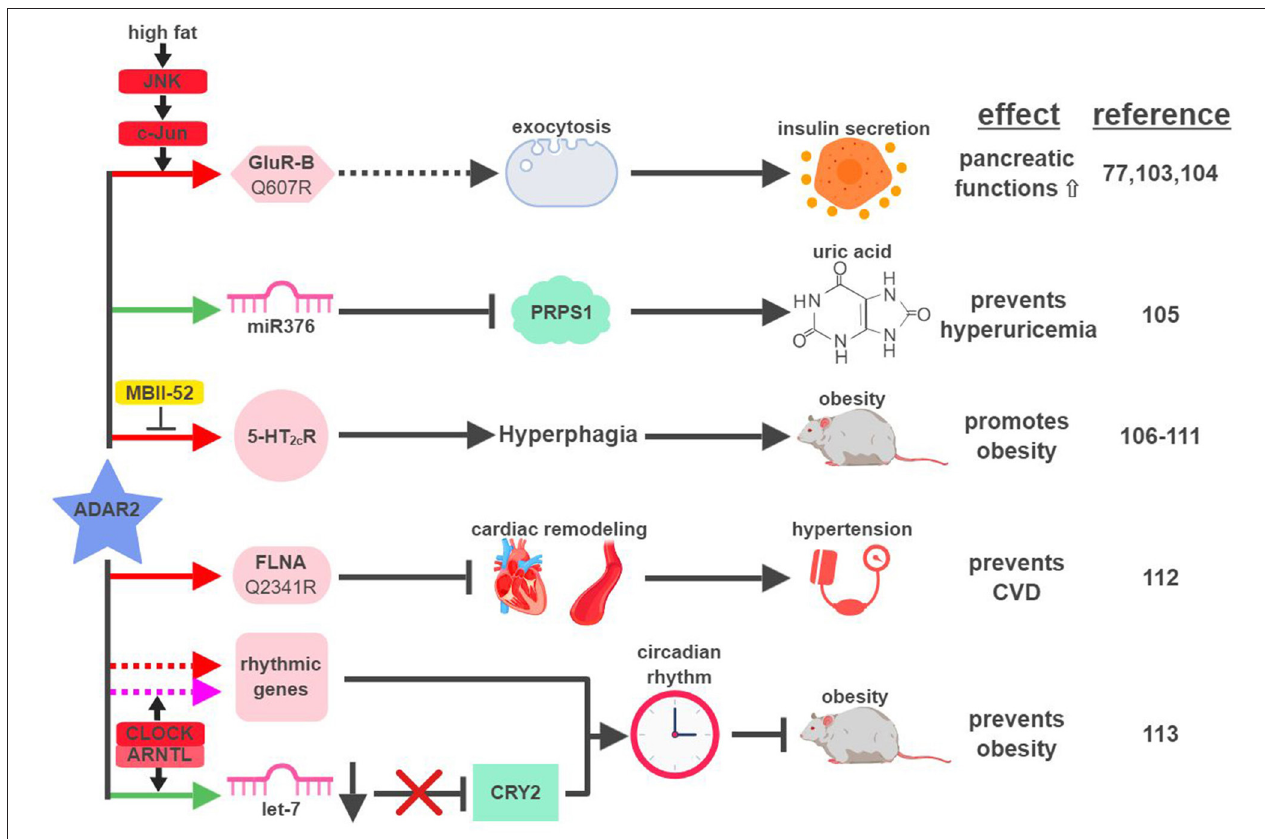
FIGURE 6 | ADAR2-mediated RNA editing in metabolic disorders. The color of the first arrow in each pathway indicates the mechanism (refer to Figure 1 ) by which ADAR2 regulates its direct targets, depicted in pink icons or shapes. Dashed lines indicate suggested/unproven functions/relationships. Additional activators and inhibitors of specific pathway steps are depicted in red and yellow rounded rectangles, respectively. CVD, cardiovascular disease. The figure was created with